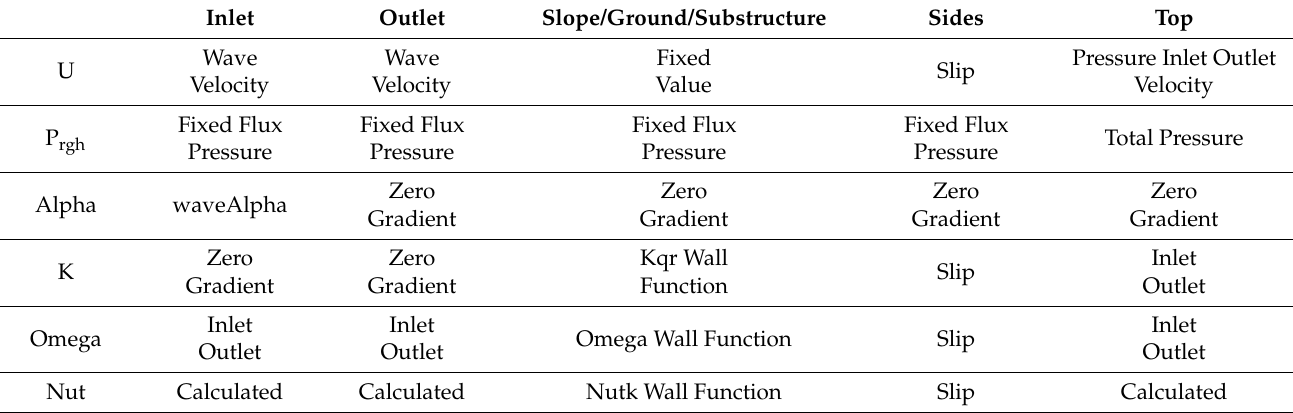
Table 6. Boundary conditions used in all simulation cases.